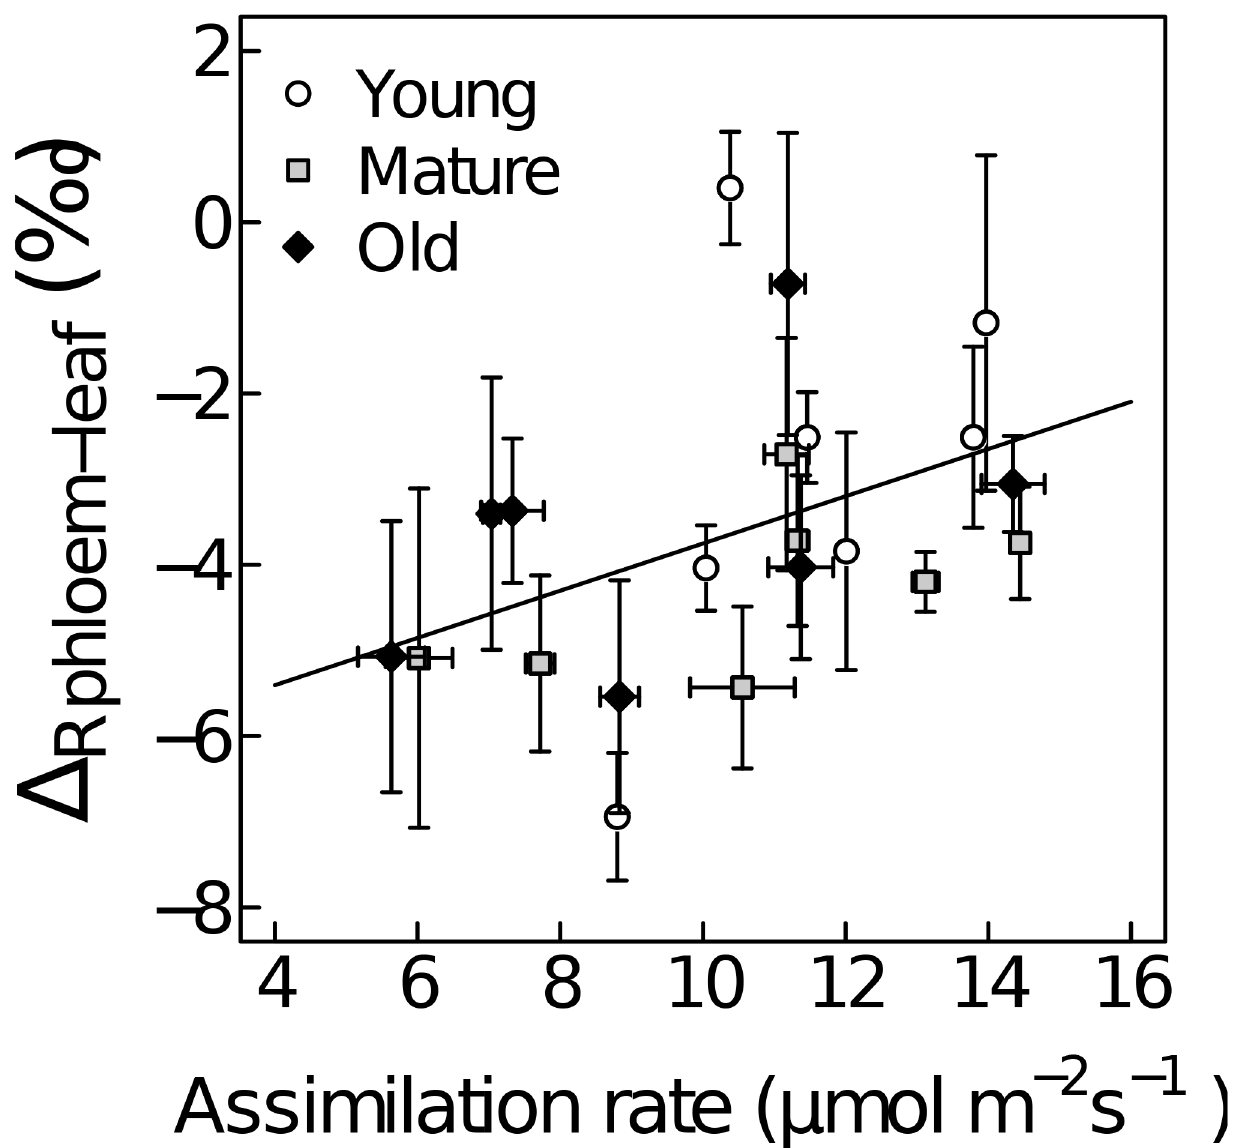
Fig 3. Response of respiratory C isotope fractionation ( Δ R ) between phloem sap organic matter and leaf-respired CO 2 ( Δ Rphloem-leaf ) to leaf assimilation rate at three ontogenetic stages: young foliage (young, white circles), maximum growth rate (mature, grey squares) and beginning of senescence (old, black diamonds). Each point represents the average value (n = 6) for a given plant species at a given ontogenetic stage. The regression is given across all species and ontogenetic stages and based on the average values (y = 0.28x-6.51, R 2 = 0.19, p = 0.051). Error bars indicate ± 1SE.